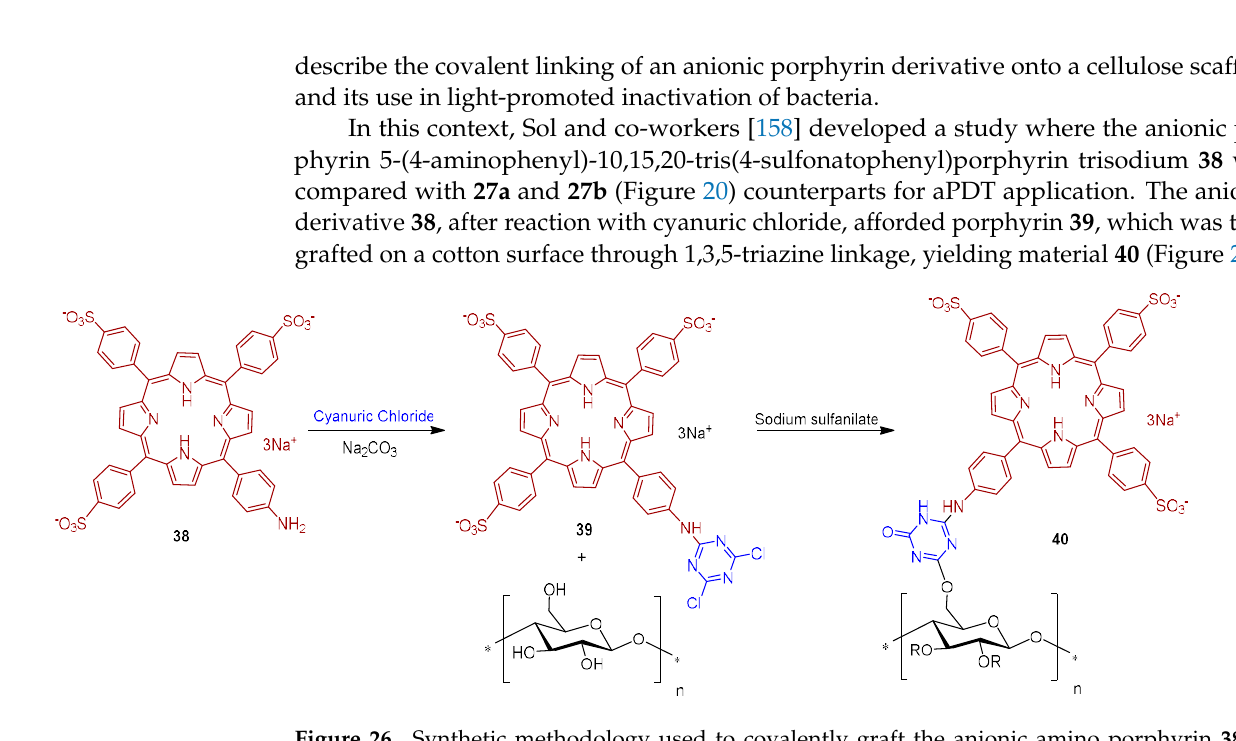
Figure 26. Synthetic methodology used to covalently graft the anionic amino porphyrin 38 on cellulose fabrics via cyanuric chloride approach (Adapted from reference [158] ).